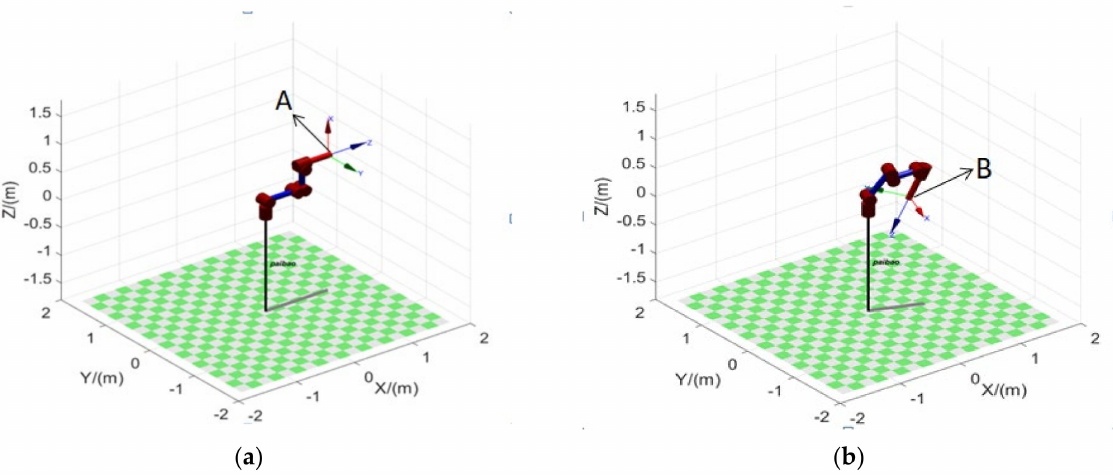
Figure 6. MATLAB simulation diagram: ( a ) Initial position and orientation; ( b ) Terminal position and